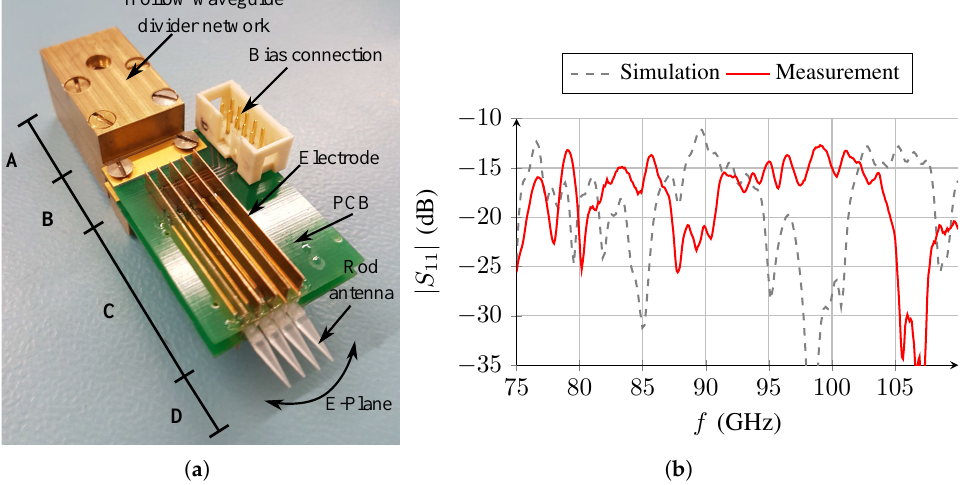
Figure 31. ( a ) Fully assembled demonstrator with PCB for maintaining electrode position and bias connection, Sections A to D according to Figure 29. ( b ) Simulation and measurement of the input